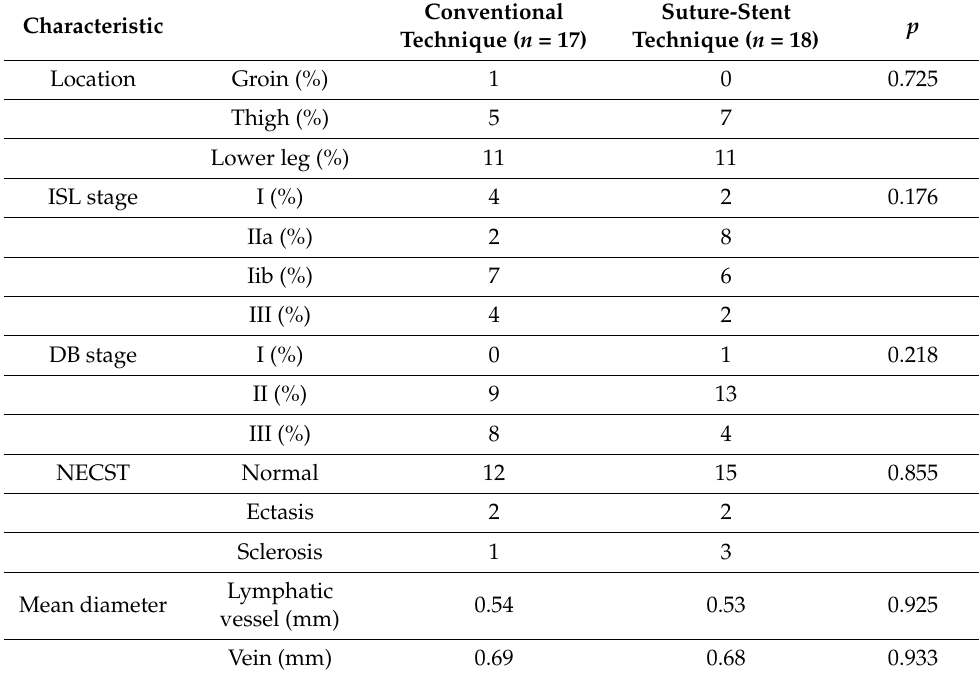
Table 2. Comparison of the anastomosis demographics between the conventional technique group and the suture-stent technique group.